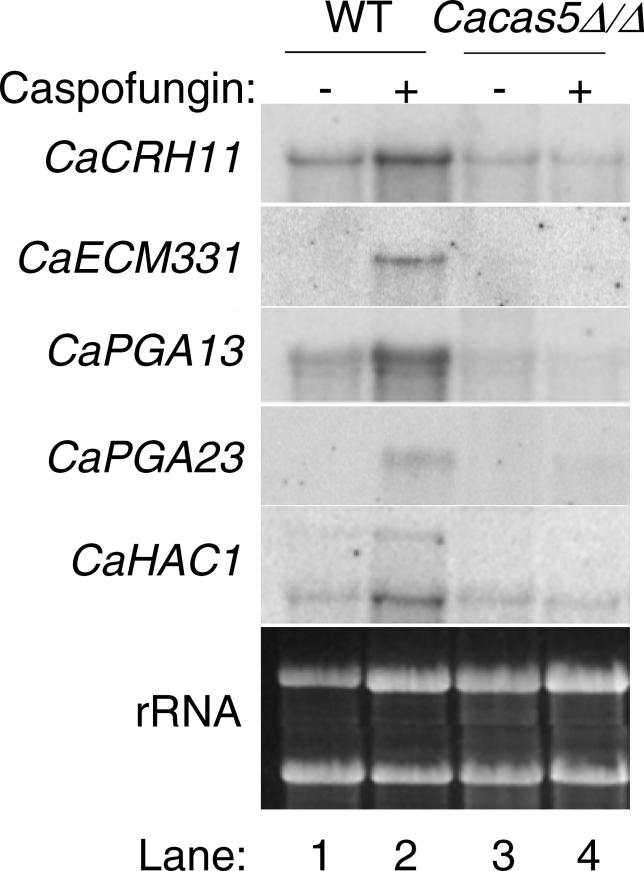
Dependence of Caspofungin-Responsive Genes on CaCas5Reference strain DAY185 and prototrophic Cacas5Δ/Δ mutant VIC1186 were grown and treated with 125 ng/ml caspofungin as described for Figure 2. RNA was prepared for Northern blot analysis and probed for the indicated transcripts. The rRNA bands visualized with ethidium bromide staining were used as a loading control.